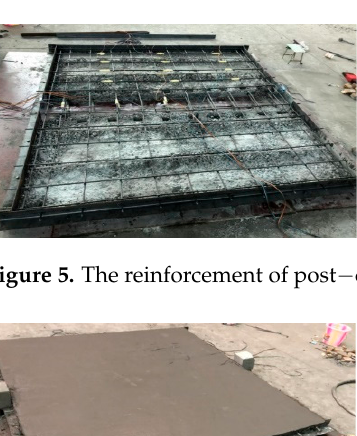
Figure 4. The reinforcement of laminate bottom plate test specimens.